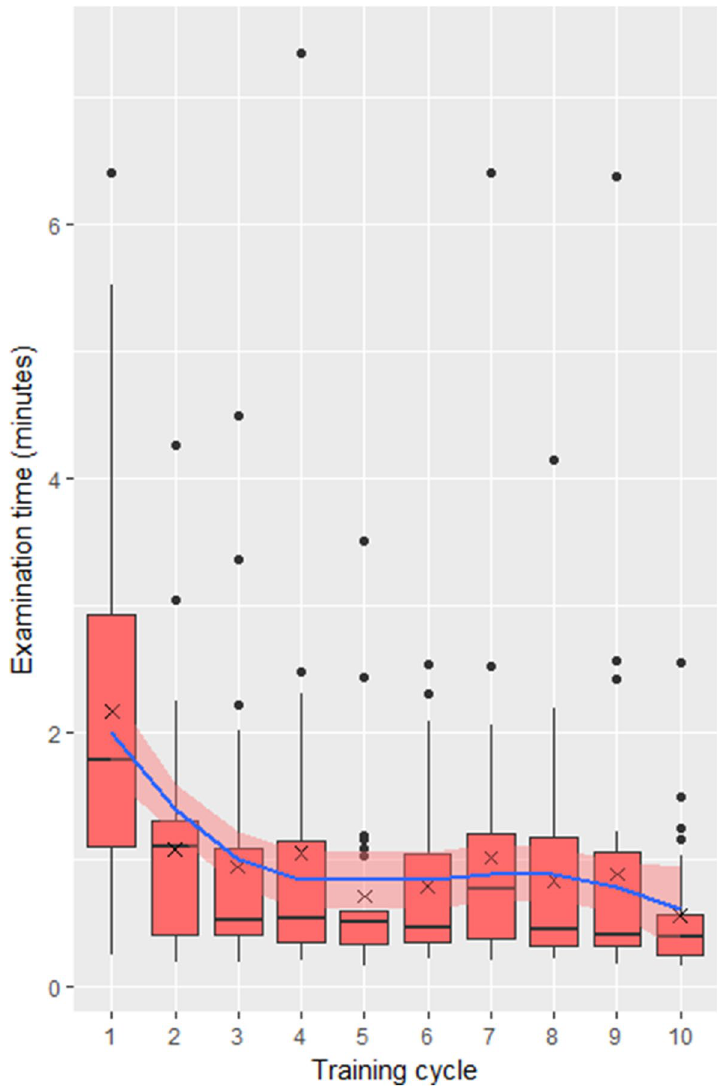
Figure 2. Effect of training on examination time. Boxplot values over 1.5 interquartile range below the first quartile or above the third quartile were defined as outliers. Crosses indicate the mean. The blue line indicates a local polynomial regression fitting with 95% confidence intervals in light